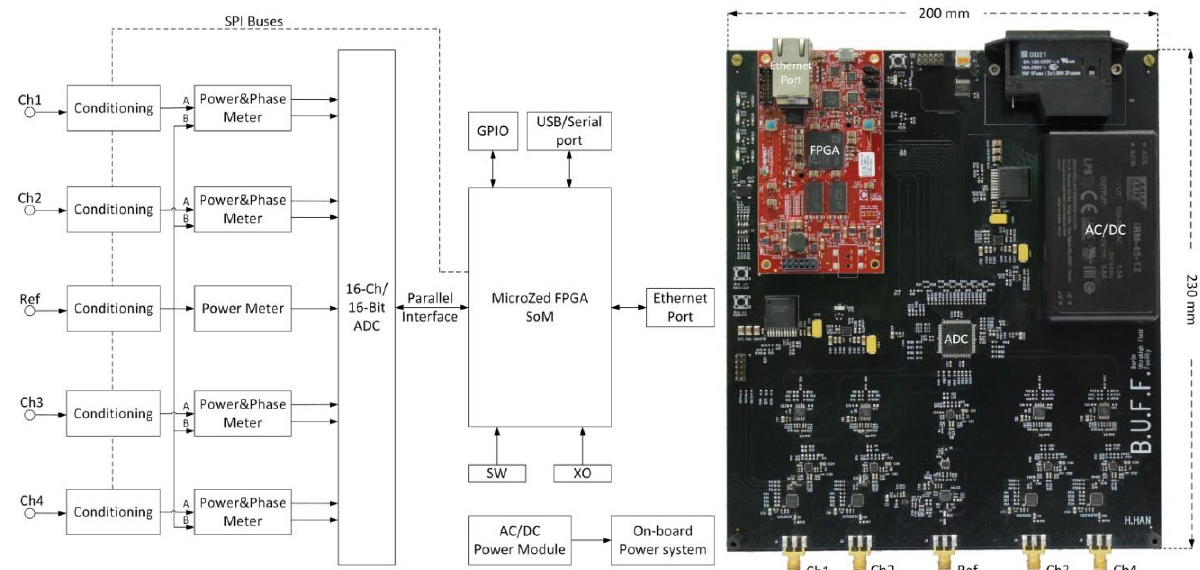
Figure 1. Left: System block diagram of the supervision module. One power meter was implemented in the reference channel whereas identical power and phase meters were implemented in the radio frequency (RF) input channels. Two serial peripheral interface (SPI) buses were routed from the FPGA (field-programmable gate array) to the conditioning chips for configuration. The FPGA receives data from the analog-to-digital converter chip through its parallel interface. The Ethernet interface was utilized for data exchange. The on-board power system distributes various DC (direct current) power supplies to components on the board. GPIO: general-purpose input/output; SoM: system-on-module; SW: switches; XO: crystal oscillator; ADC: analog-to-digital converter. Right: A photo of the supervision module. The red module is a system-on-module unit (AES-Z7MB-7Z020-SOM-I-G, Avnet, Phoenix, AZ, USA). Please note that the photo is rotated by 90 degrees versus the block diagram shown on the left-hand side.